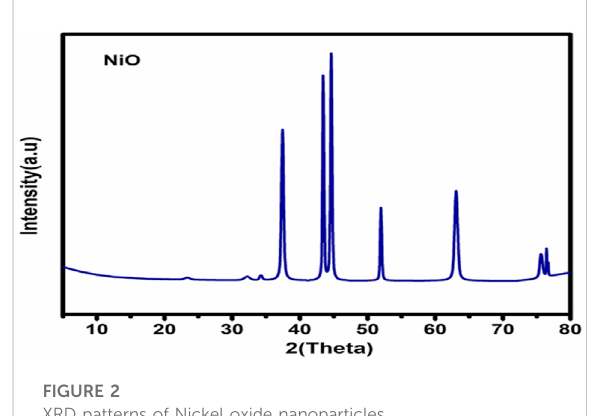
FIGURE 2 XRD patterns of Nickel oxide nanoparticles.